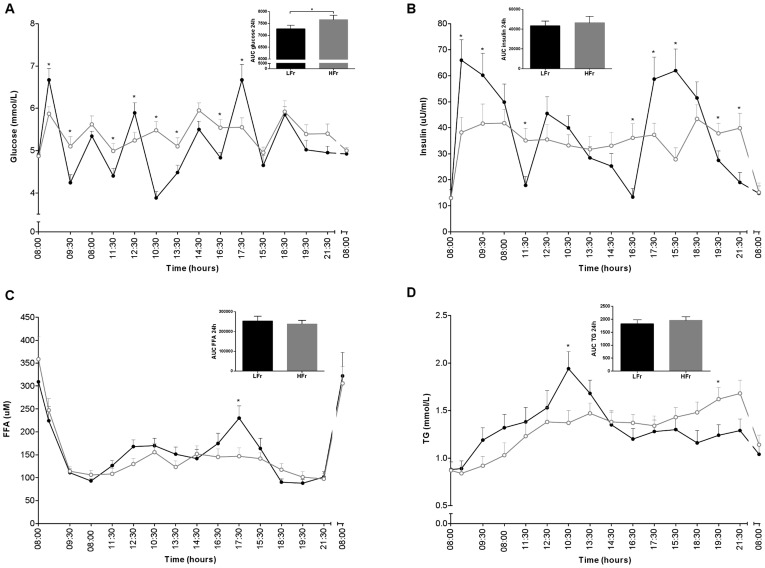
Glucose (A), insulin (B), FFA (C) and TG (D) levels for 24 h and the AUCs of the LFr (dense black circle) and HFr (open gray circle) diet.*P<0.05 LFr vs. HFr diet. P-values were derived by analysis of mixed models for the 24h profiles and by a paired t-test for the AUCs. aValues are expressed as mean±SEM.